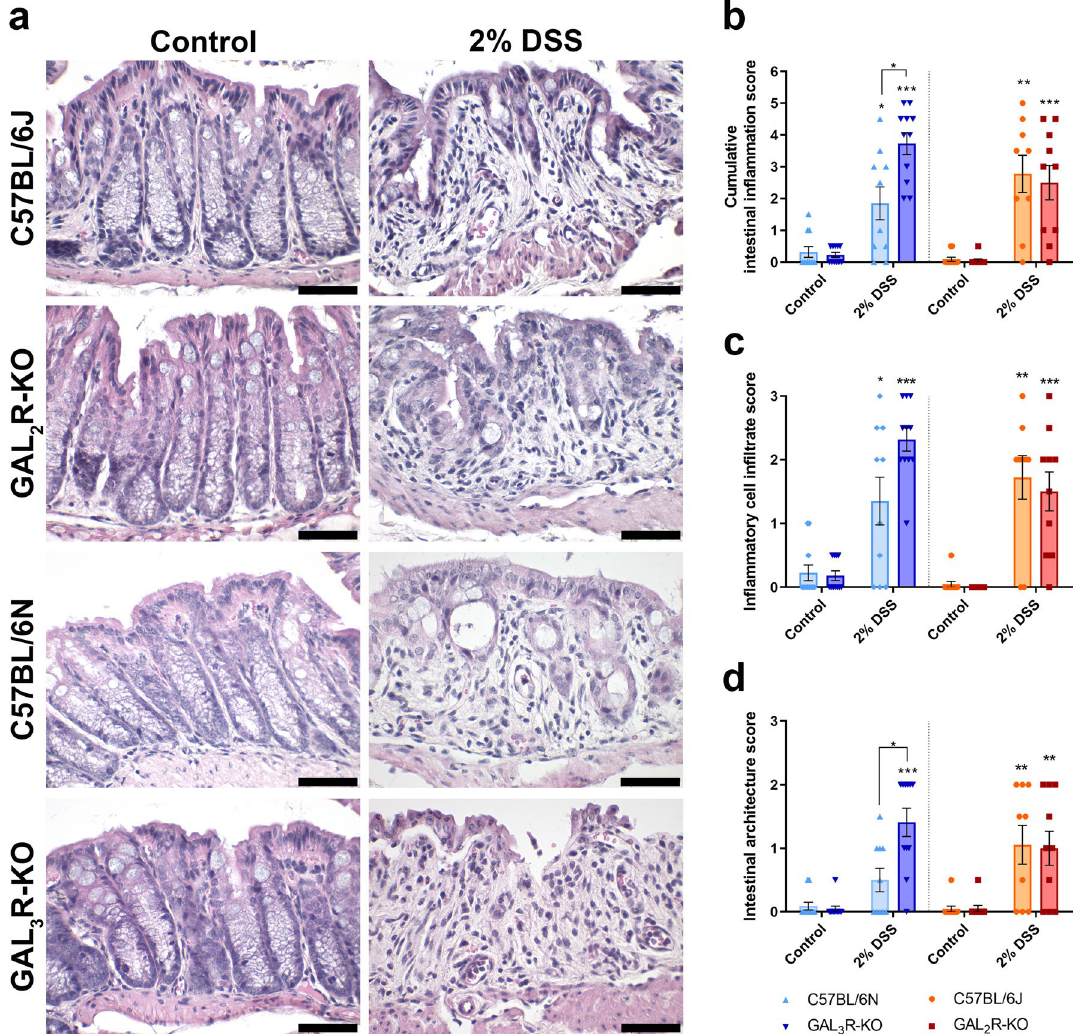
Figure 3. Intestinal inflammation in the distal colon of GAL 3 R-KO, GAL 2 R-KO and corresponding WT mice. Representative images of HE staining (Scale bar: 50 µm) ( a ). Cumulative semiquantitative scores of intestinal inflammation ( b ). Score points for inflammatory cell infiltrate ( c ). Score points for intestinal architecture ( d ). Data represent means ± SEM. n = 9–11. Data were analyzed by Kruskal–Wallis test followed by Mann–Whitney U test. * p < 0.05; ** p < 0.01; *** p < 0.001 versus corresponding controls or as